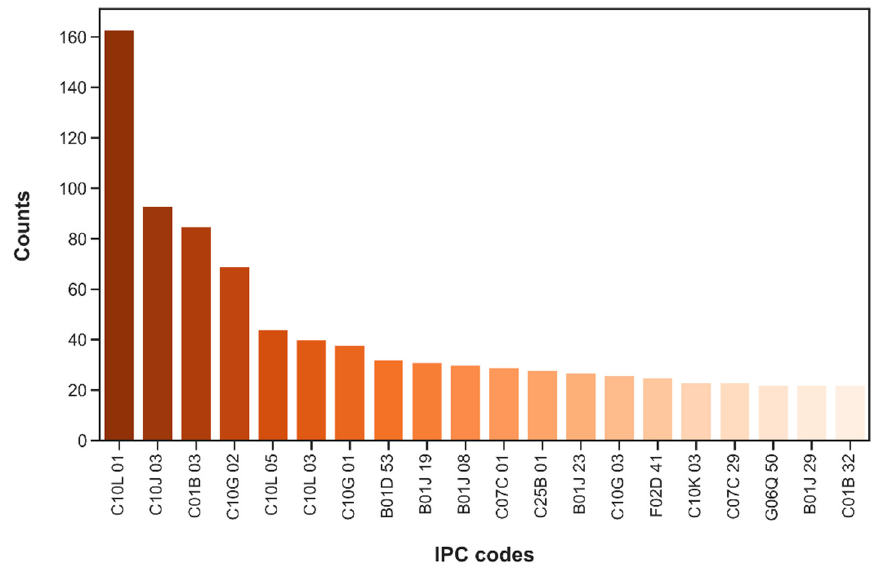
Figure 6. Top 20 frequently occurring IPCs. (Note: IPCs also refer to knowledge areas in subsequent descriptions).